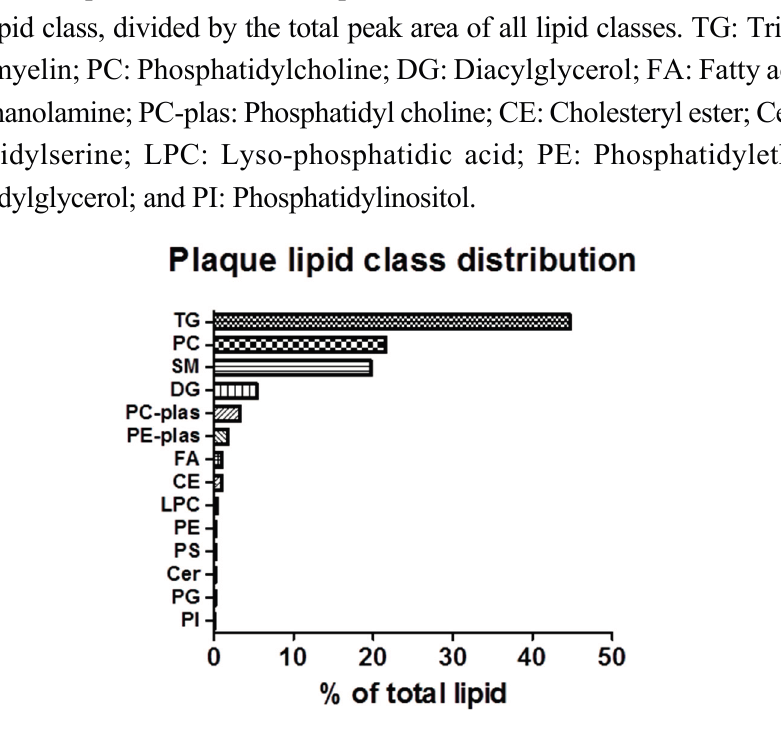
Figure 3. Summary of aortic lipid class distribution: Targeted analysis of lipids was conducted on full-length aortae isolated from rabbits fed the HC diet by UPLC/TOF-MS. Data is expressed as the percent of the lipid class of the total lipid content in the aorta, calculated as the total peak area of each lipid class, divided by the total peak area of all lipid classes. TG: Triacylglycerol; SM: Sphingomyelin; PC: Phosphatidylcholine; DG: Diacylglycerol; FA: Fatty acid;